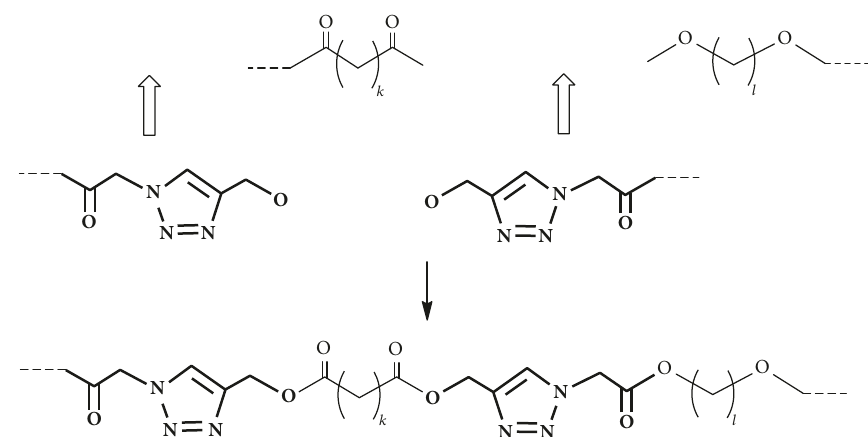
Figure 5: Schematic representation of PEs as products of the insertion (empty arrows) of 1,2,3-triazole-containing fragments (given in bold) between ester bonds of poly(alkylene